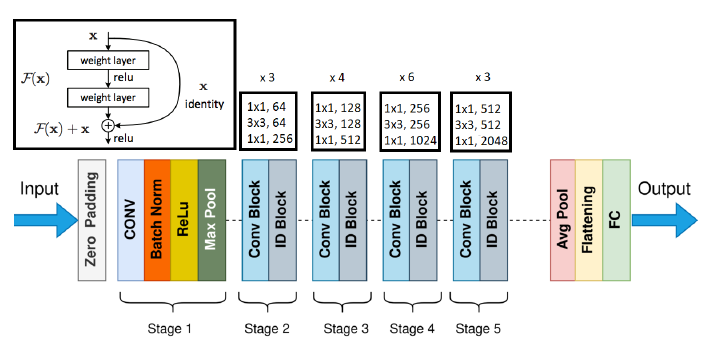
Figure 6. The structure of ResNet 50 model [19], distributed under a CC BY-SA 4.0